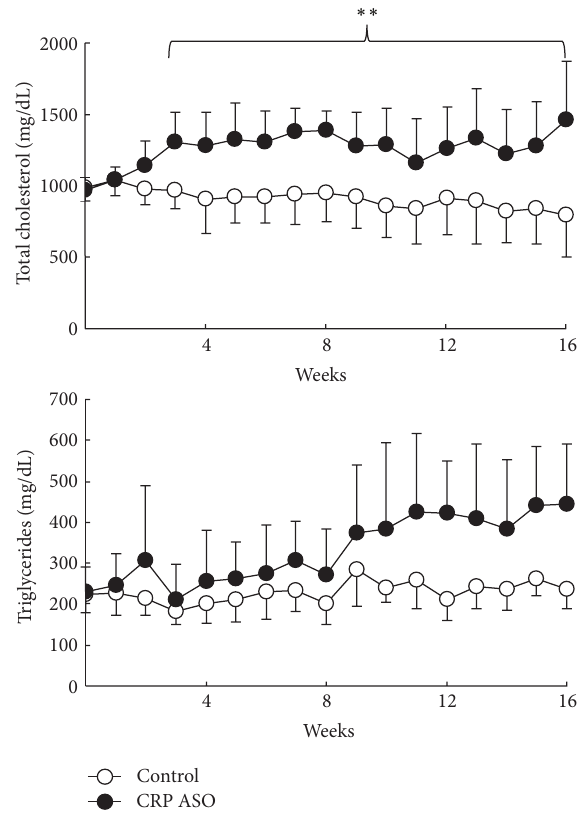
Figure 2: Analysis of plasma levels of lipids. CRP ASO treatment increased plasma lipids (TC and TG). Data are combined from male and female rabbits and expressed as the mean ± SD. 𝑛 = 4 -5 for each